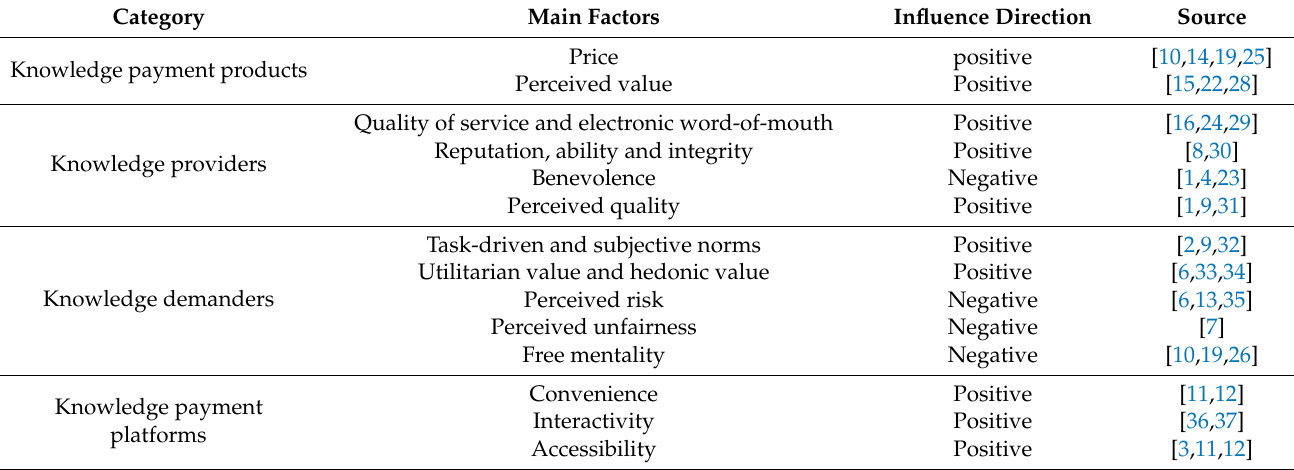
Table 1. Factors influencing knowledge payment